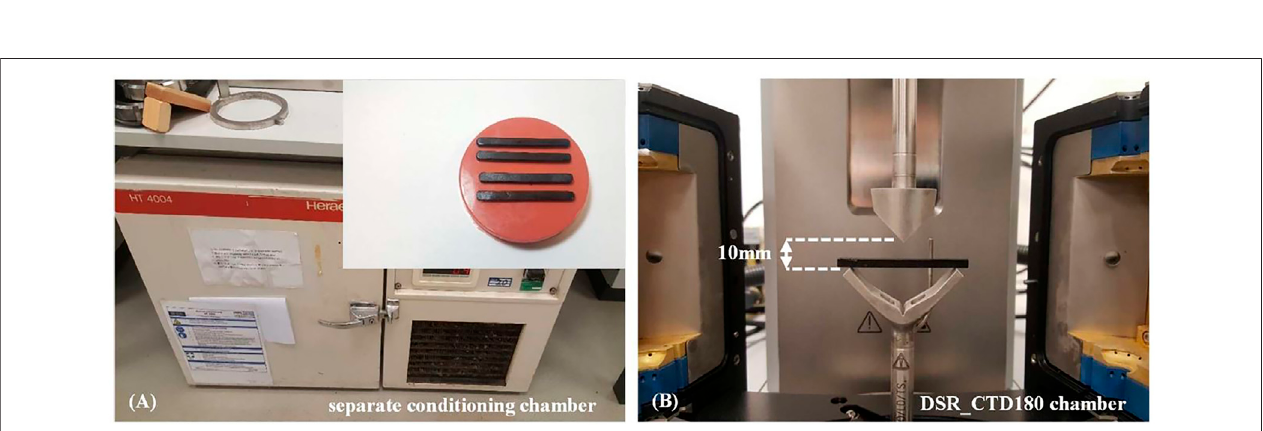
FIGURE 3 | (A) Silicone specimen molds placed in conditioning chamber, (B) specimen placed on bearings.